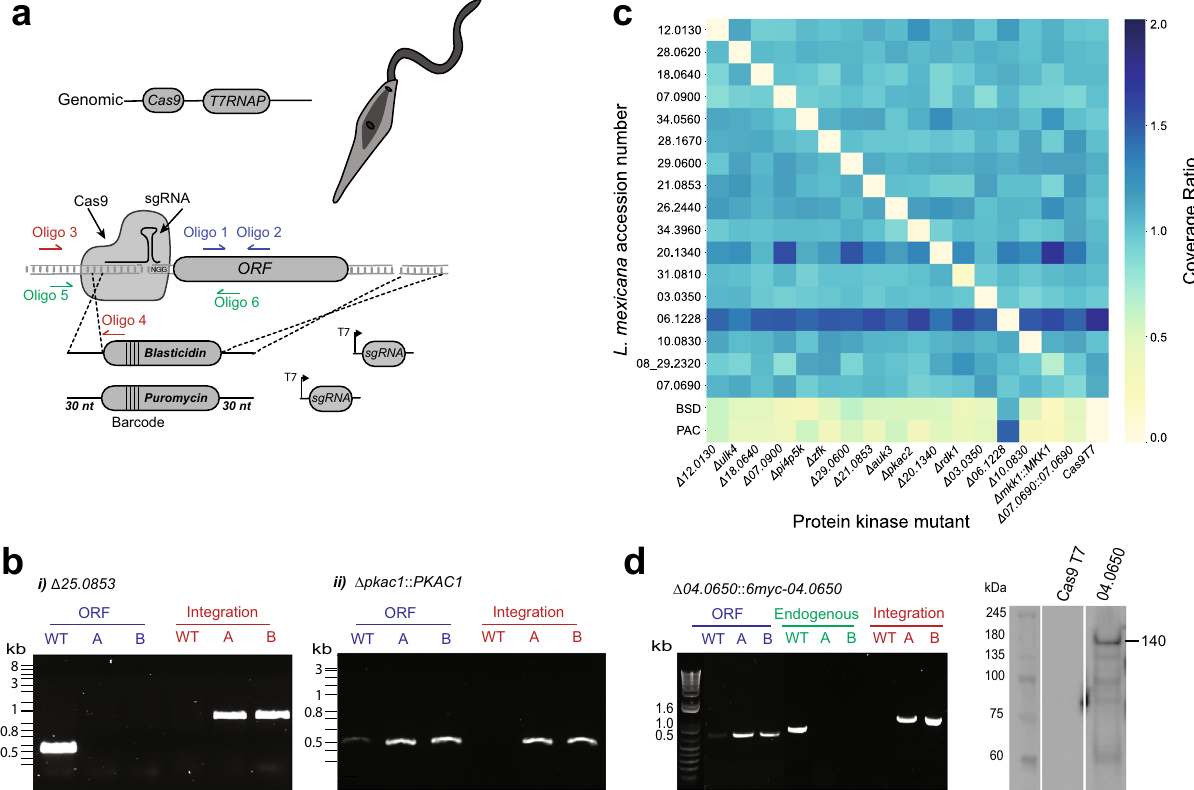
Fig. 2 Generation of the L. mexicana kinome gene deletion library. a Schematic representation of gene editing by CRISPR – Cas9 in the L. mexicana progenitor cell line showing the integration of repair cassettes containing 30nt homology sites, a unique barcode and antibiotic-resistance genes for puromycin ( PAC ) and blasticidin ( BSD ). Diagnostic PCRs for the presence of the coding sequence (CDS) with Oligo 1 and Oligo 2, (depicted in blue), correct integration of the repair cassettes using Oligo 3 and Oligo 4 (depicted in red), and the gene in the endogenous locus with Oligo 5 and Oligo 6 (depicted in green). b Diagnostic PCR for (i) LmxM.25.0853 and (ii) PKAC1 ( LmxM34.4010 ) using primer pairs as above in L. mexicana Cas9T7 (WT) and Populations A and B. c Heat map indicating the presence or absence of target genes after whole-genome sequencing. The ratio of gene coverage to chromosome coverage was used as a measure of gene copy number in selected mutants. A value of 1 represents two alleles of a given gene. d Diagnostic PCR for facilitated gene deletion mutant LmxM.04.0650 using Oligo 1 and 2 for the CDS, Oligo 5 and 6 for the endogenous locus and Oligo 3 and 4 for correct integration. Western blot using anti-myc con fi rmed the episomal expression of LmxM.04.0650 at the anticipated size of 140 cytoplasm (48.5%), basal body (11.6%), nucleus (10.1%), endo- membrane (7.1%), fl agellum (6.5%), lysosome (6.5%), fl agellar